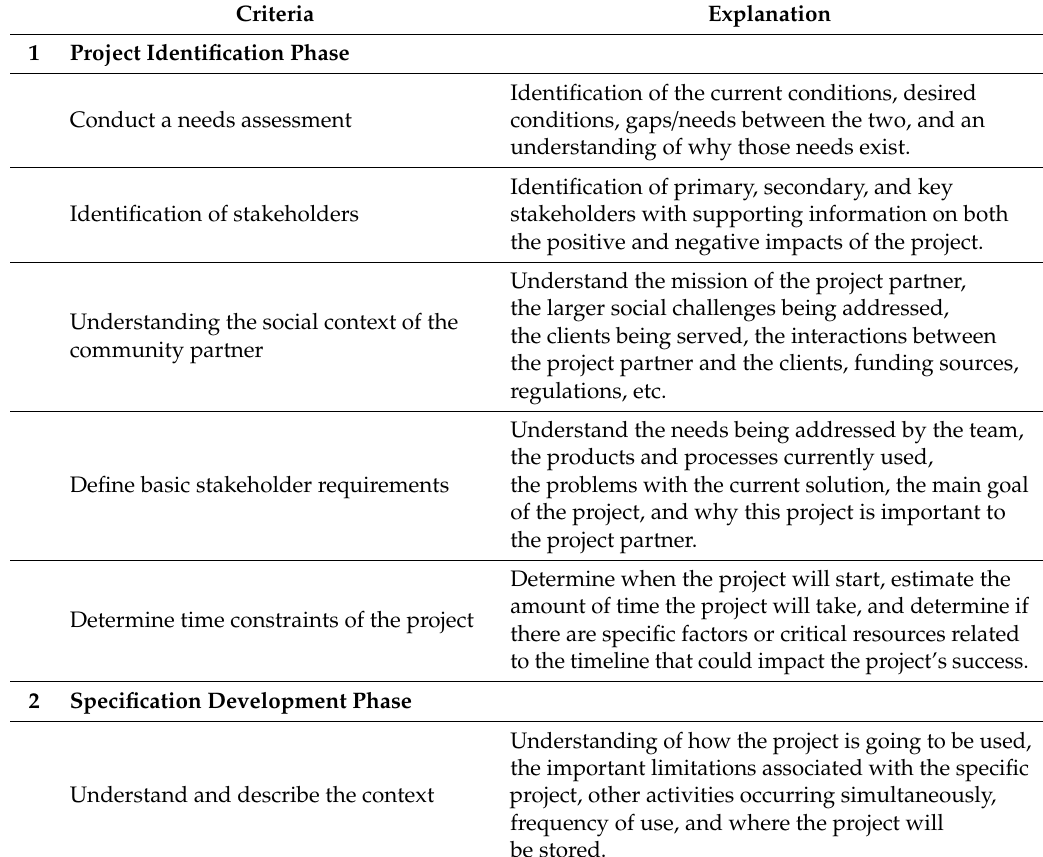
Table 8. Rubric for the final